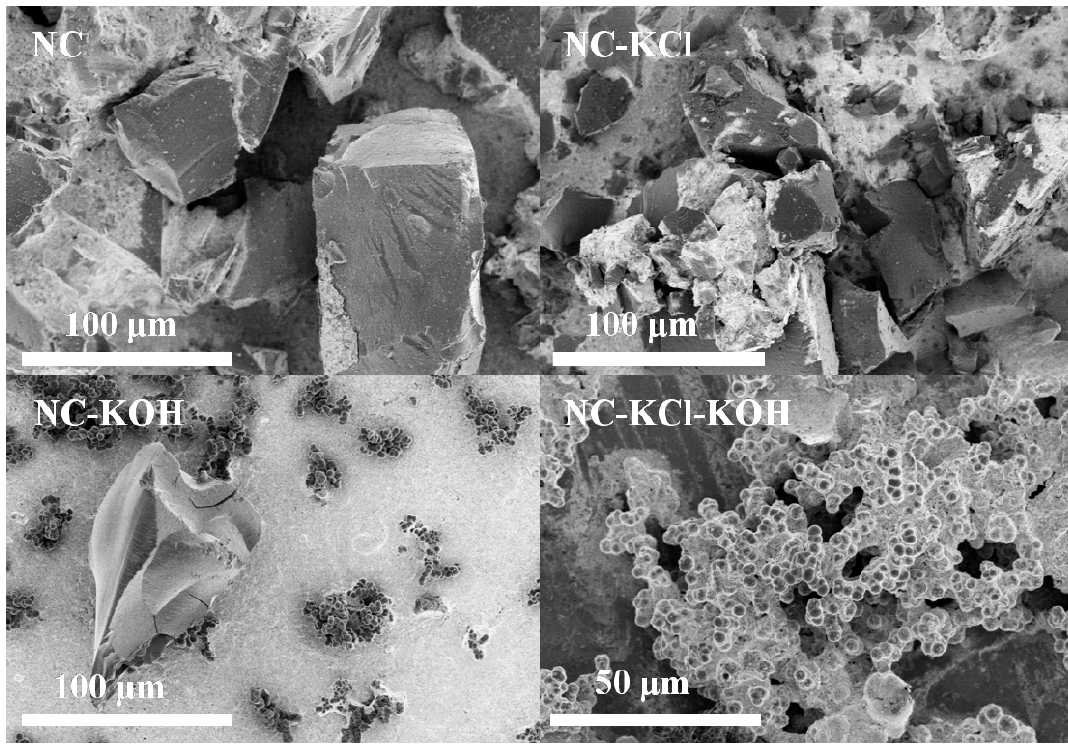
Figure 13. SEM image of typical samples and their precursors.